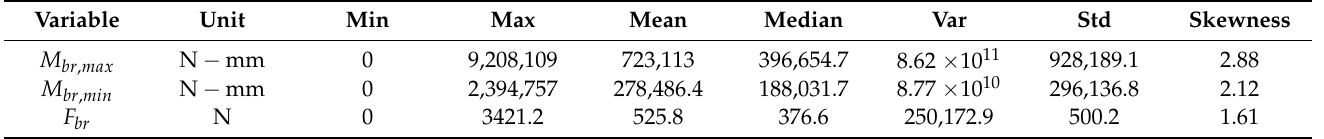
Table 6. Ranges of design parameters for output parameters used in this